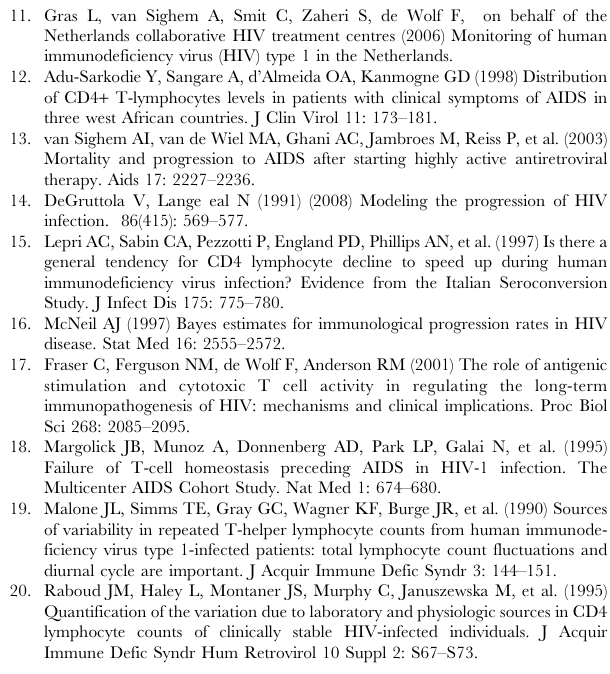
Figure S1 Sensitivity analysis. The analysis shown in Figure 2 in the main text is repeated using alternative assumptions about the CD4 cell count level at which treatment is initiated: (A) at 200 cell per microlitre or less; (B) at 350 cells per microlitre or less. The blue squares show the observed data; the red cross show the model simulation with the parameters chosen to reflect conditions in each treatment centre; the green circles show the model simulation when the parameters are chosen to reflect conditions in each treatment centre, with the exception that the distribution of CD4 cell count among patients entering care is the same in all